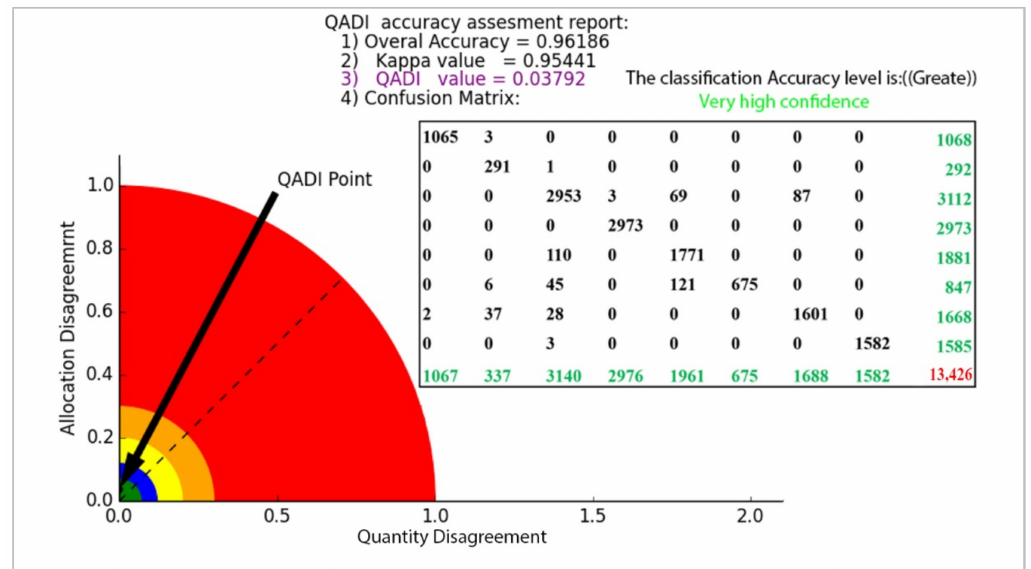
Figure 11. The QADI graph forthe error matrix of LULC classification based on ANN (Table 10) developed by Leeuwen et al.